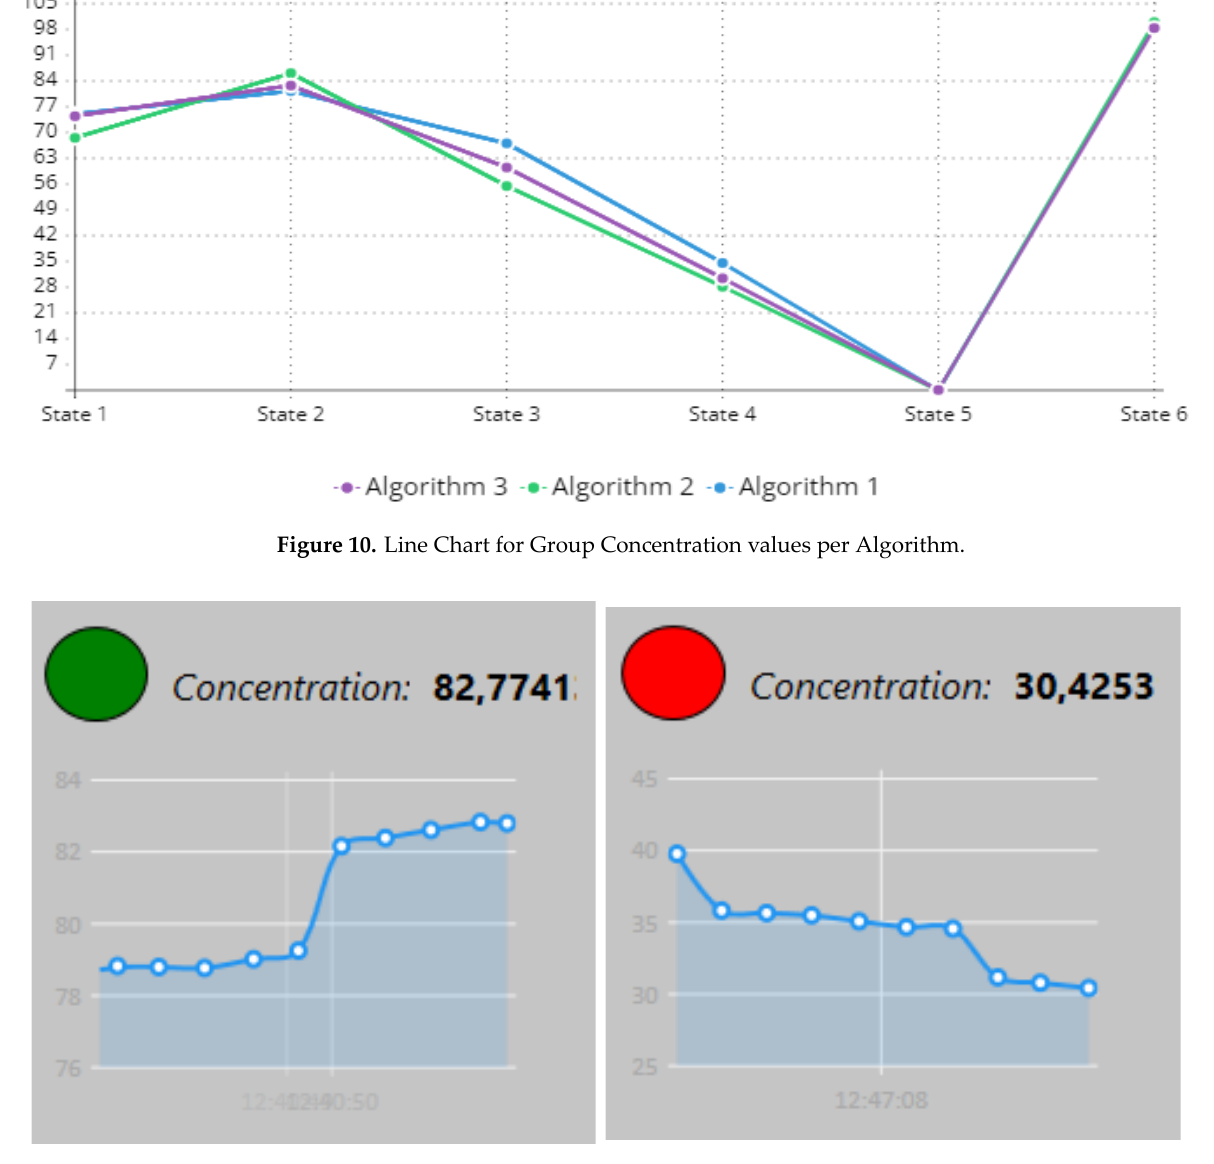
Figure 11. Charts for algorithm 3. Large steps per Group Window.